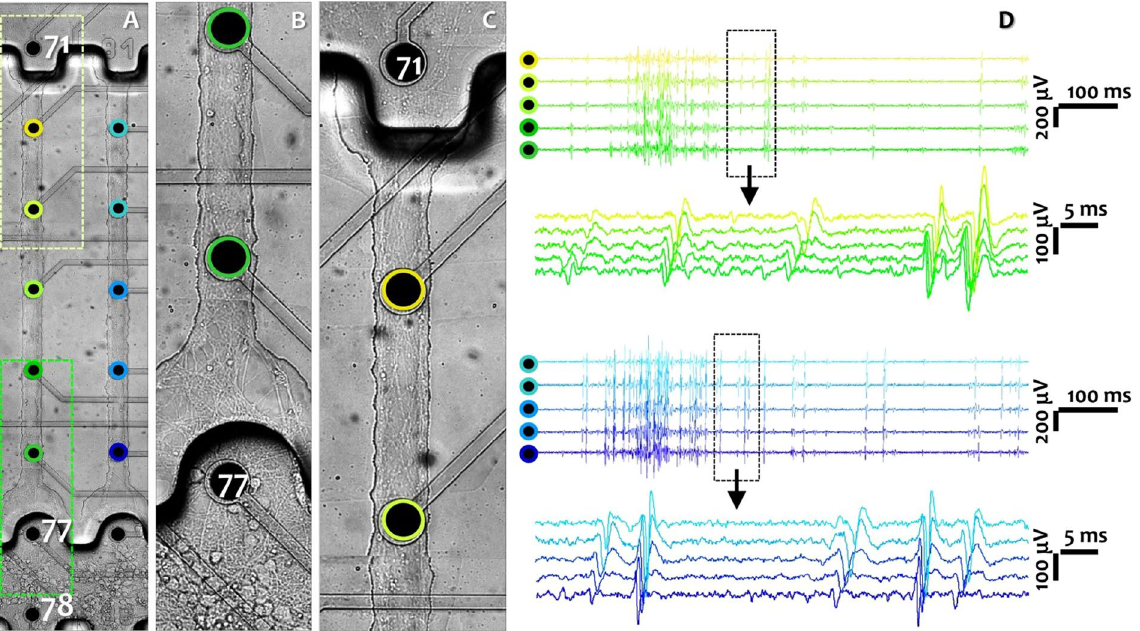
Figure 2. Imaging axonal morphology and recording its extracellular activity at 10 DIV. ( A ) Two reservoir modules (somal compartments, bottom) and microchannels with axonal projections. Axons are passing the neurite filtering region before reaching the microchannel entrance. Two electrodes are recording from each reservoir module. Five subsequent electrodes recorded from each microchannel. ( B) Magnified view of one reservoir module and its dendrite buffer region (lower green rectangle in A). ( C) Magnified view of counterpart compartment with exiting axons (upper yellow frame in A). ( D) Long-term window of axonal activity (1 s) from subsequent electrodes of a wide (green circles in A and green signals in D) and narrow (blue circles in A and blue signals in D) microchannels. The dashed-rectangles (60 ms) zoom onto the propagating action potentials in a wide and a narrow microchannel (green and blue, respectively). Each panel shows different propagation velocities. The whole culture morphology at 10 DIV including all 8 modules is shown in Suppl. Fig. 2. Electrode pitch: 200 µ